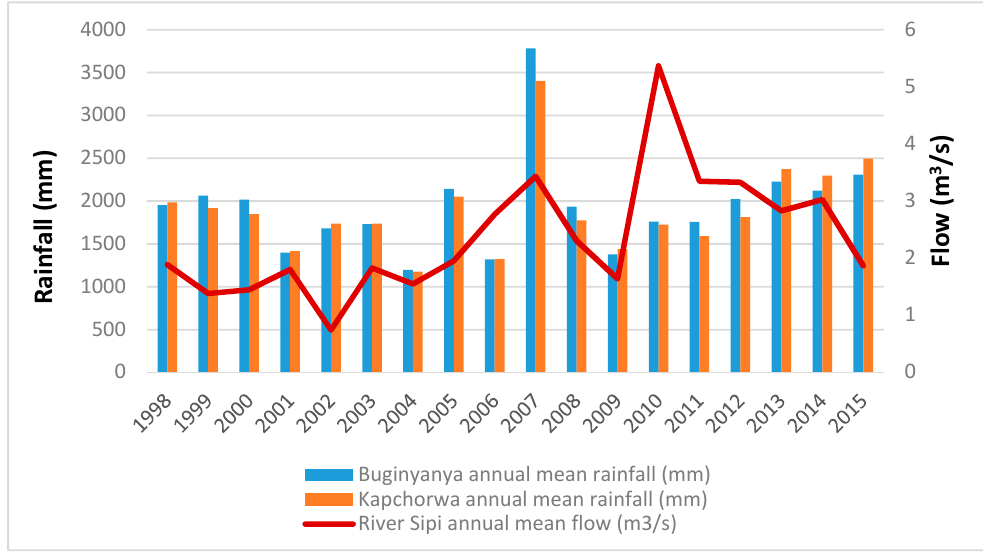
Figure 4. Annual patterns of rainfall in Buginyanya and Kapchorwa and River Sioi flow (1998–2015).